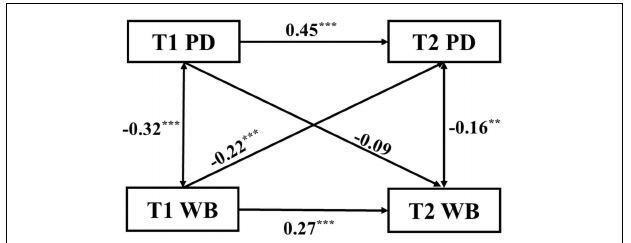
FIGURE 2 | Cross-lagged model of perceived discrimination and wellbeing. PD, Perceived discrimination; WB, Wellbeing; T1, Time 1; T2, Time 2; ** p < 0.01; *** p < 0.001.